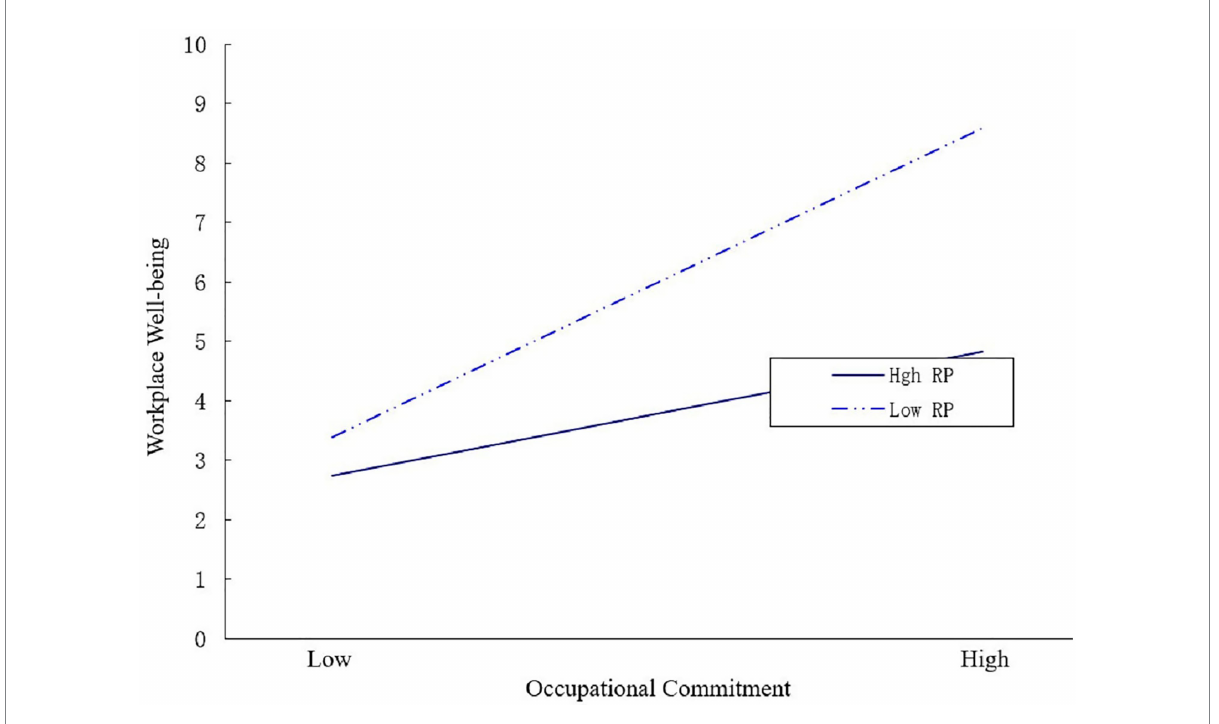
FIGURE 2 Interactive effects of occupational commitment and risk perception on workplace